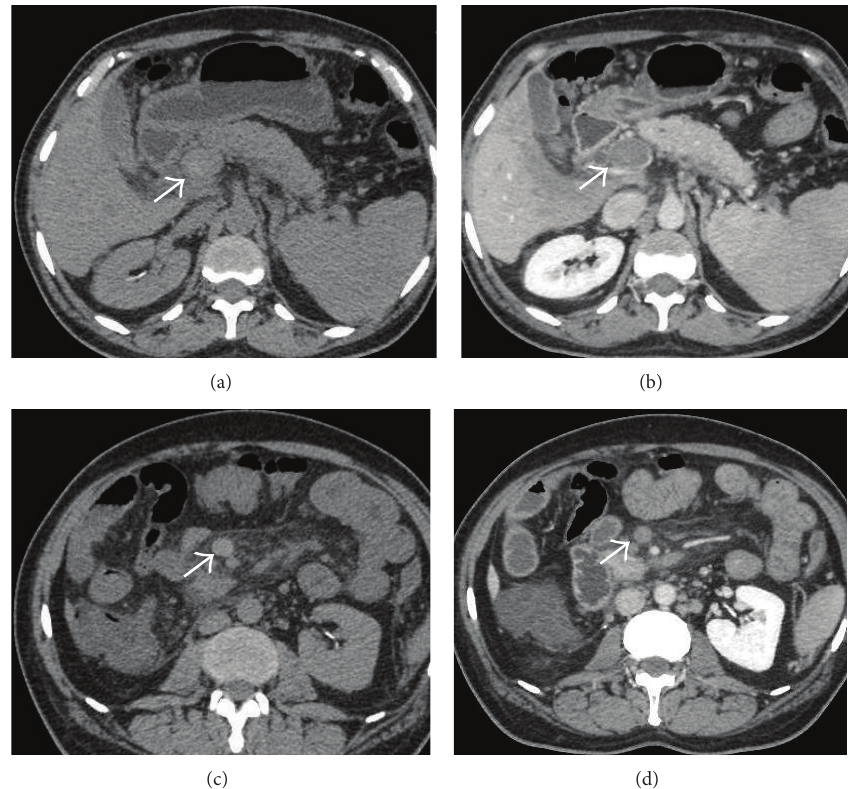
Figure 35: Axial NCCT (a) and CECT (b) images demonstrating mildly hyperdense thrombus occluding the main portal vein (arrows). Corresponding images at a caudal level in the same patient showing hyperdense thrombus in the SMV with associated fat stranding in the adjoining